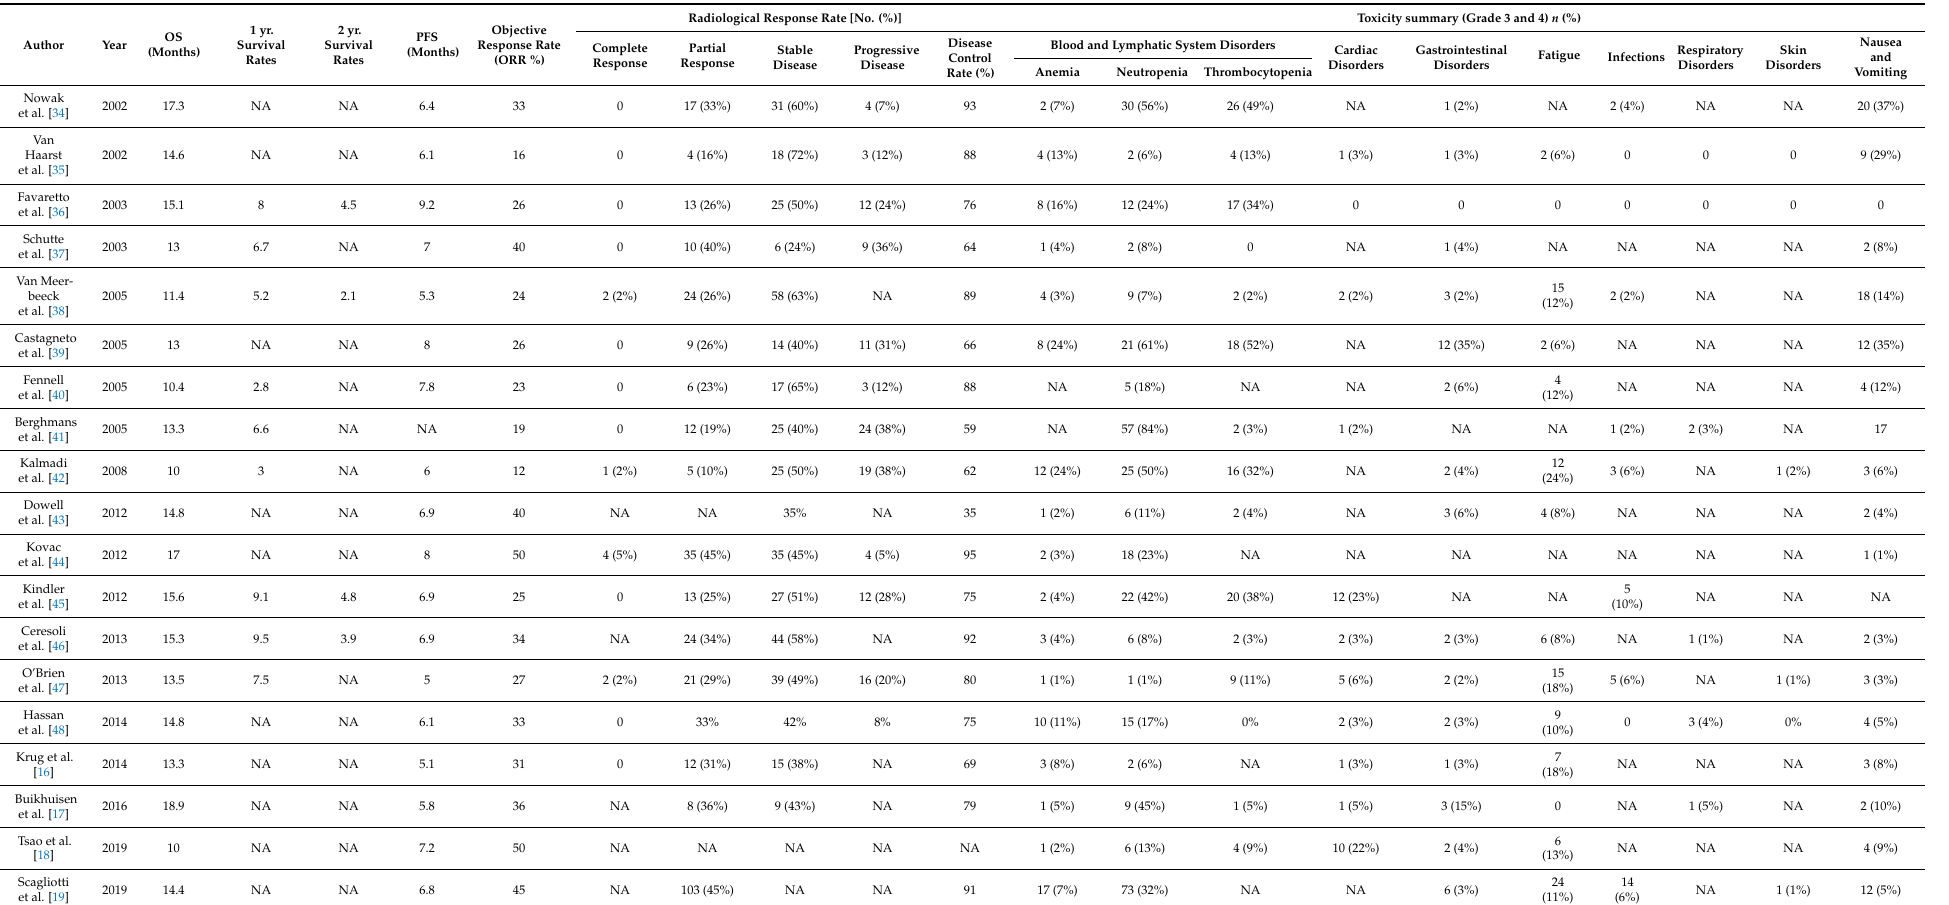
Table A2. Treatment outcomes, radiological response, and toxicity summary for malignant pleural mesothelioma patients treated with experimental therapies, negative on phase II/III